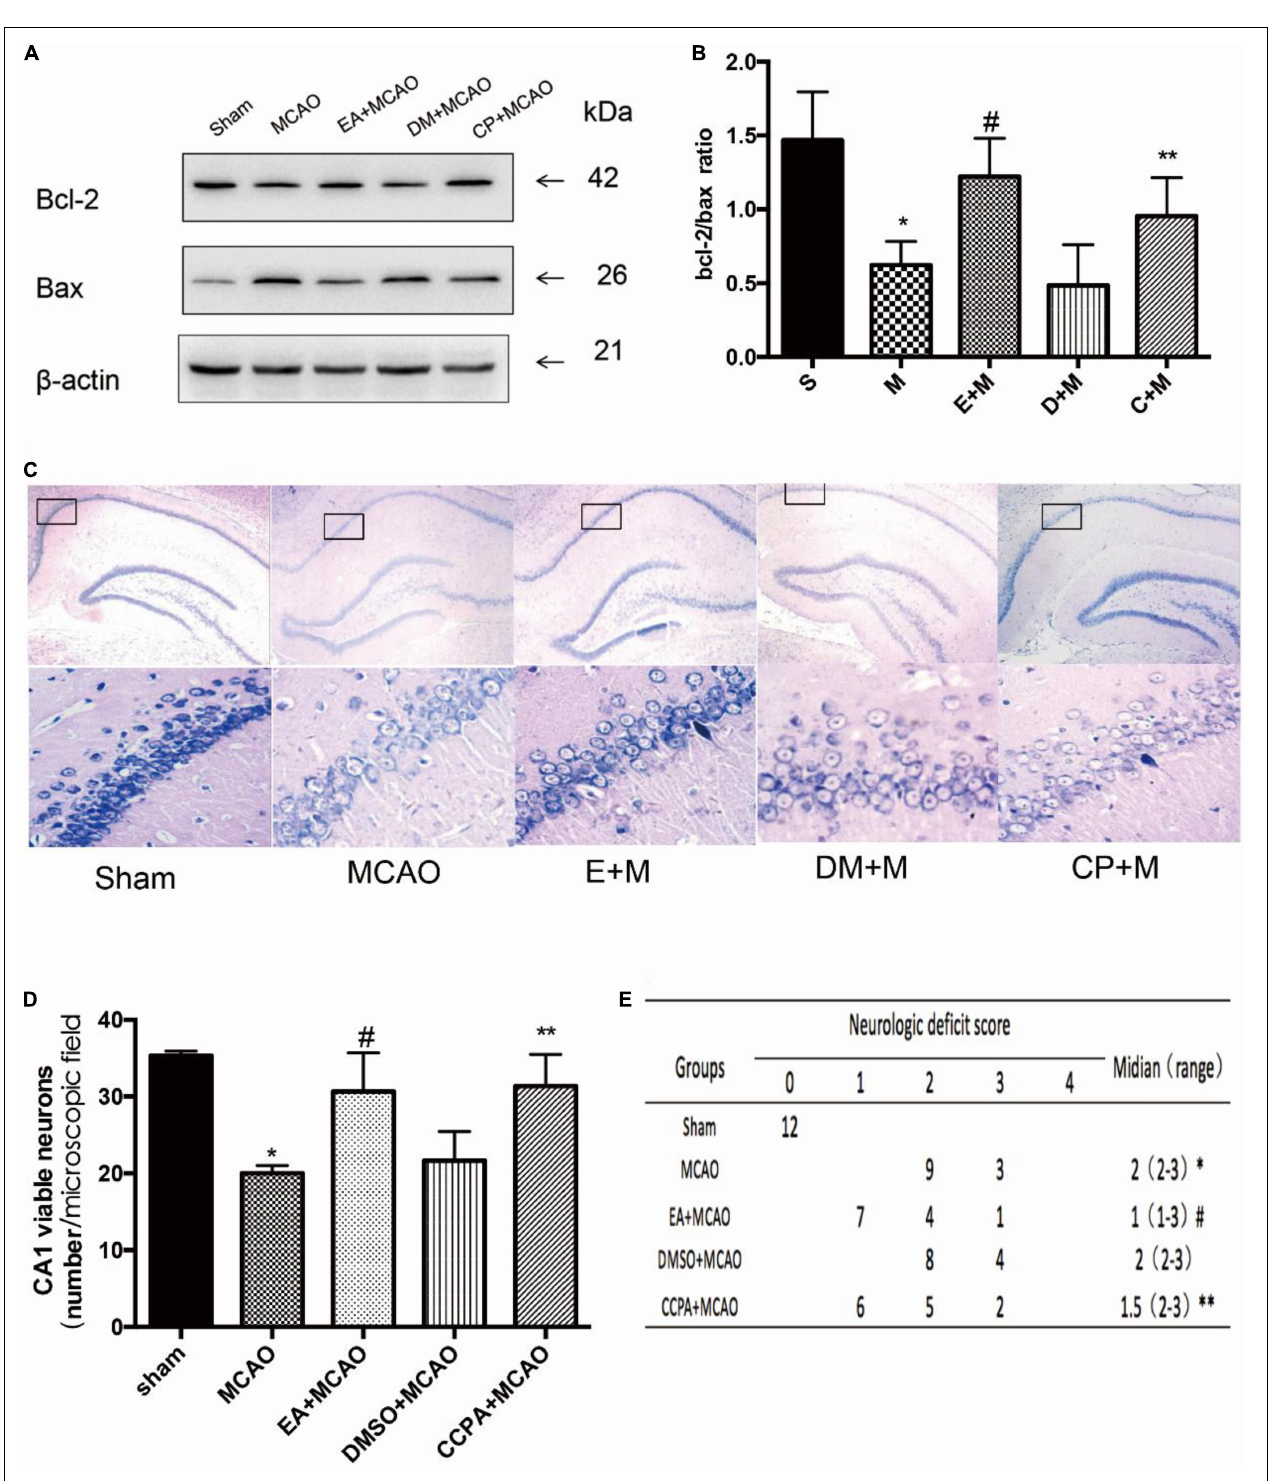
FIGURE 3 | Effect of electroacupuncture (EA) pretreatment and administration of CCPA on the effect of hippocampus damage. (A,B) Western blot analysis for Bcl-2 and Bax protein expression in the hippocampus ( n = 3). (C,D) Nissl staining of hippocampus 24 h after reperfusion. Cell counting shows a significant decrease in the number of viable neurons in the hippocampal CA1 region for the middle cerebral artery occlusion (MCAO) group, while the number is significantly increased in the EA + MCAO group and CCPA + MCAO group ( n = 3). (E) Neurologic behavior scores were determined 24 h after reperfusion. * P < 0.05 vs. the sham group, # P < 0.05 vs. the MCAO group, ** P < 0.05 vs. the MCAO group.